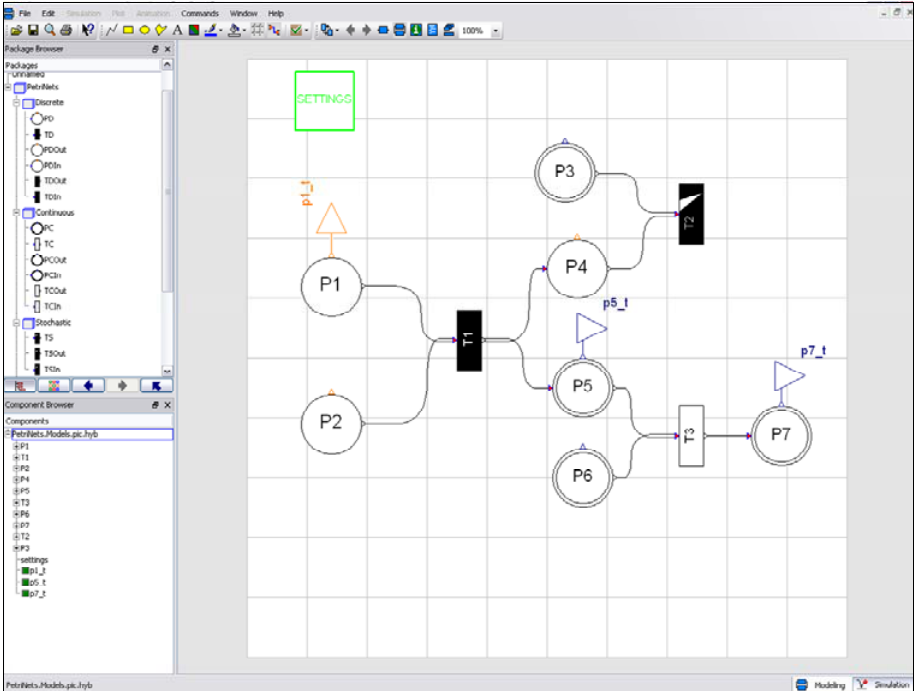
Figure 15: Graphical Modeling of Petri Nets in Dymola.